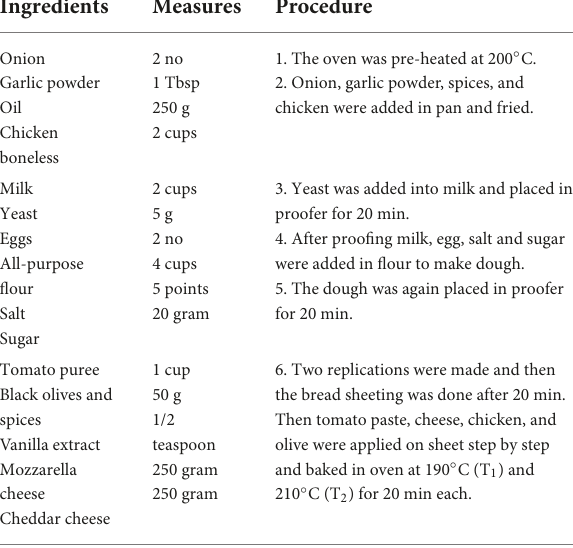
TABLE 2 Ingredients and procedure for preparation of